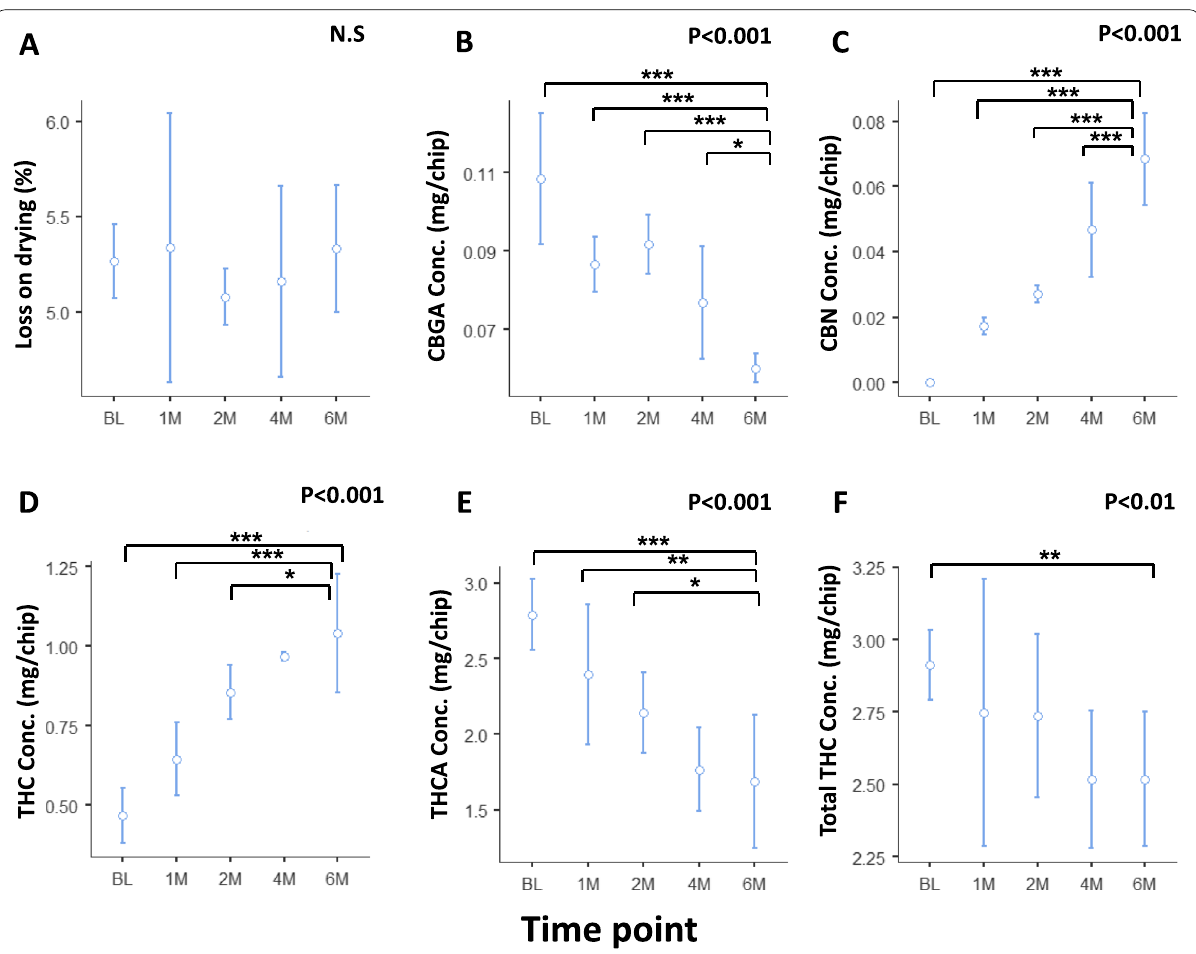
Fig. 4 Amount of major phytocannabinoids in MC stored in Syqe cartridges at 30°C over 6 months. The middle circle represents the mean value and the upper and lower lines represent the upper and lower 95% confidence interval values. BL, baseline; M, month; THC, (-)-∆ 9 -trans- tetrahydrocannabinol; THCA, (-)-∆ 9 -trans- tetrahydrocannabinol acid; CBGA, cannabigerolic acid; CBN, cannabinol; “Total” represents the sum of the acid and the neutral components. Statistically significant differences between times of storage were calculated by one-way ANOVA, utilizing Fisher’s exact test analyses (whenever significant, stated as the p value and when not significant stated as N.S), followed by a Tukey post hoc multiple comparison test (*, p <0.05; **, p <0.01; ***, p